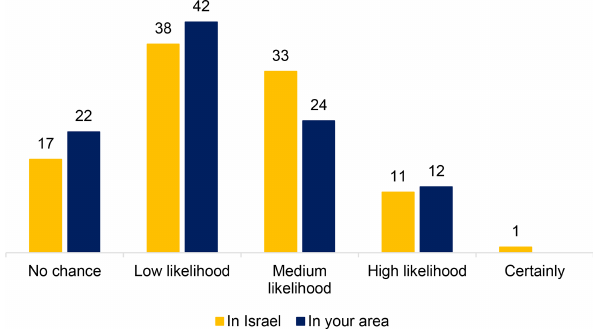
Figure 3. Level of belief that a disastrous earthquake will occur in Israel/in your area in the next 5